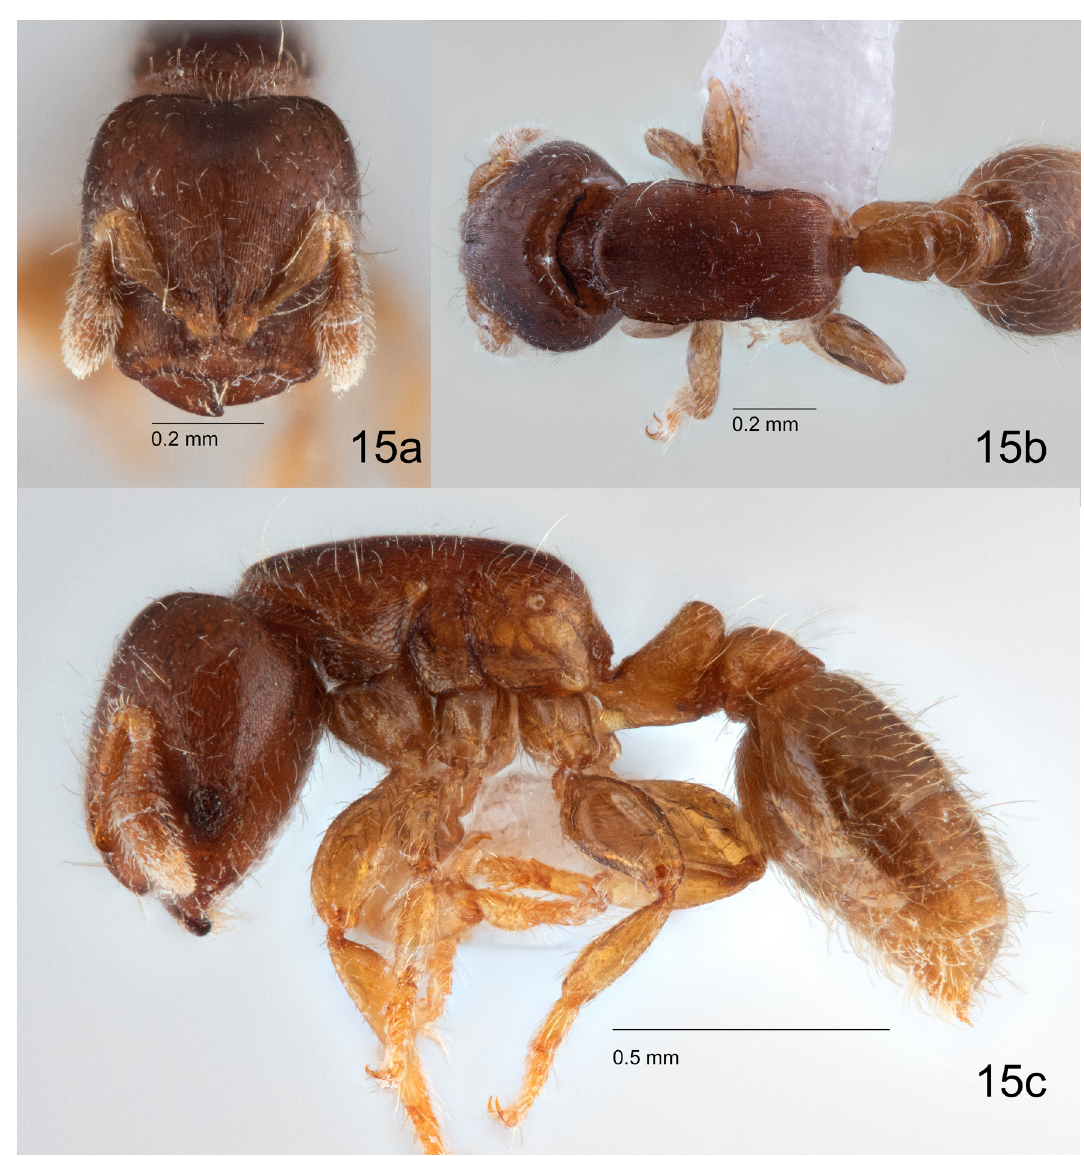
Fig. 15. Rhopalomastix robusta Wang & Jaitrong sp. nov., paratype, small worker (ZRC_ENT00013949). a . Head in full-face view. b . Body in dorsal view. c . Body in lateral